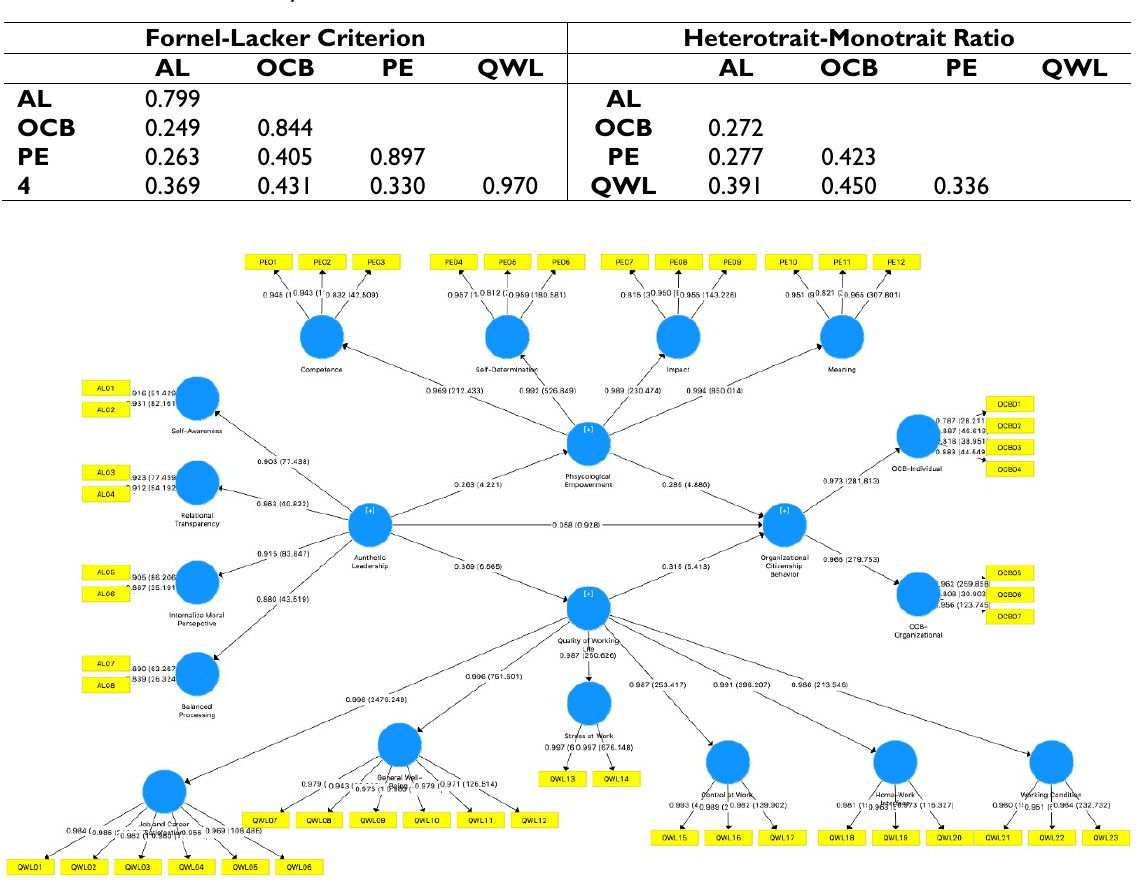
Table 3. Discriminant Validity